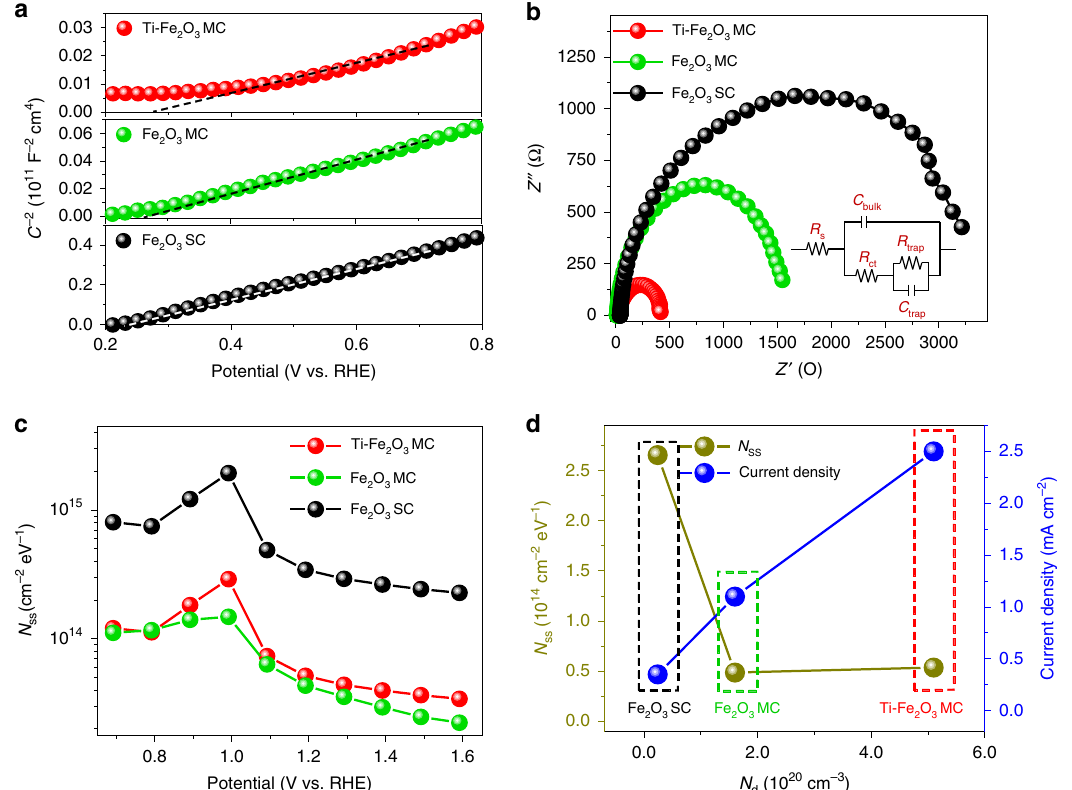
Fig. 4 Charge transfer ef fi ciencies. a Mott – Schottky plots of the samples. Capacitances ( C s) were determined from electrochemical impedance measurements at a frequency of 10 kHz in the dark. b Electrochemical impedance spectra measured for the Ti – Fe 2 O MC, Fe 2 O 3 MC, and Fe 2 O 3 SC photoanodes. The inset shows the equivalent circuit. c The energetic distribution of N SS as a function of the applied potentials. d The correlation between N N SS , d , and current density at 1.23 V vs. at 1.23 V vs. RHE with an irradiation area of 0.20 cm 2 . Both H 2 and O 2 were linearly produced over 3 h with the stoichiometric ratio (2:1). The Faradaic ef fi ciencies (FEs) for both H 2 and O 2 are